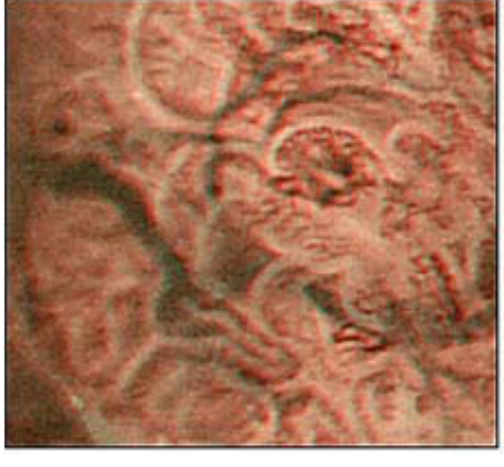
FIGURE 8. Esophagus, Barrett: narrow-band imaging coupled to magnification. Right of the image; intestinal metaplasia and a ridged pattern. Left of the image high grade dysplasia in a zone with very small crests and pits